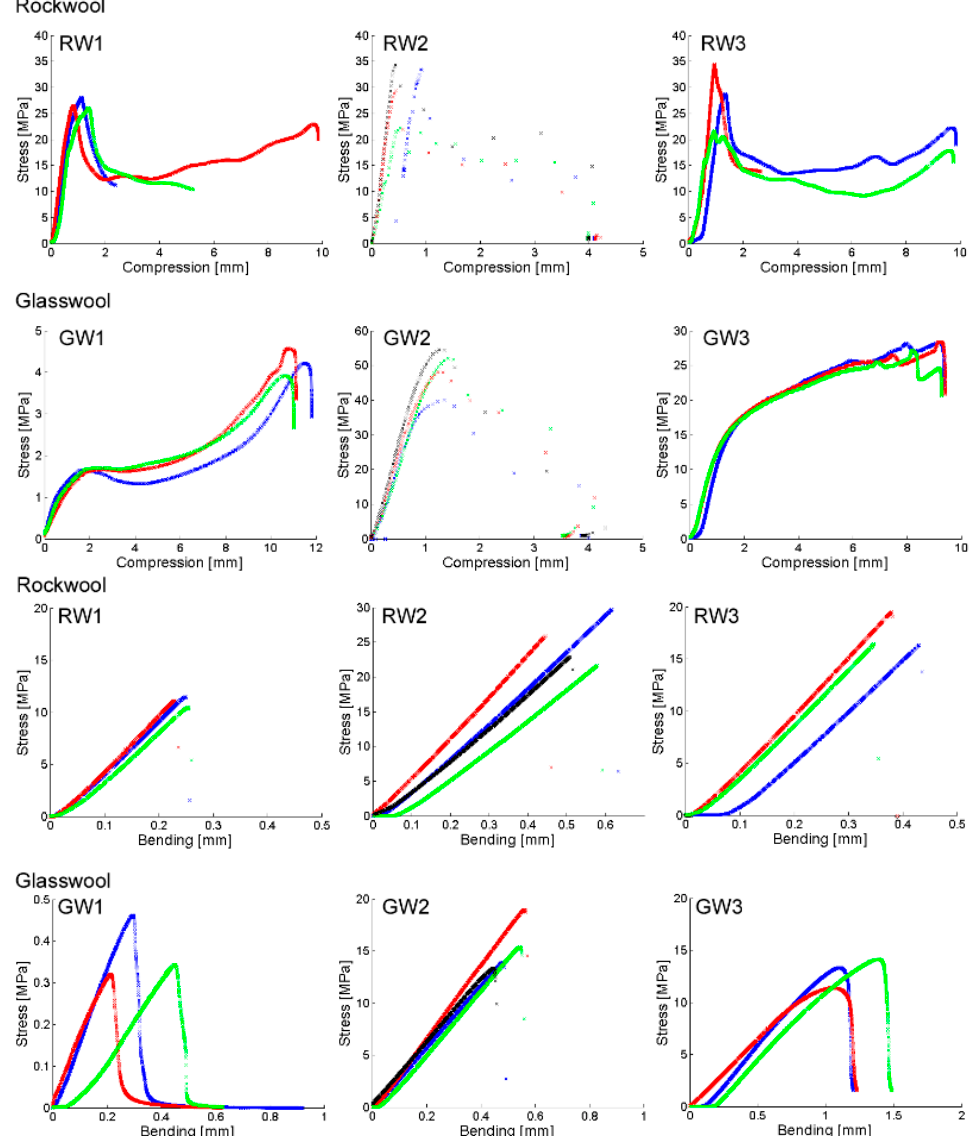
Figure A1. Stressing curves of studied mineral wool-based geopolymers under bending and compression. Each of the graphs show results of three or four different samples, which are indicated by different color.